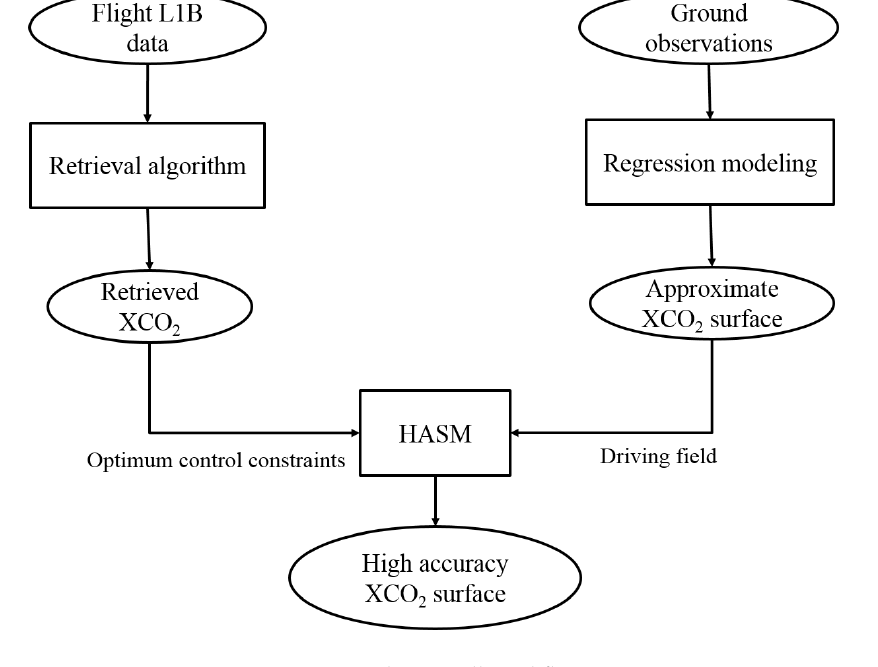
Figure 4. The overall workflow.